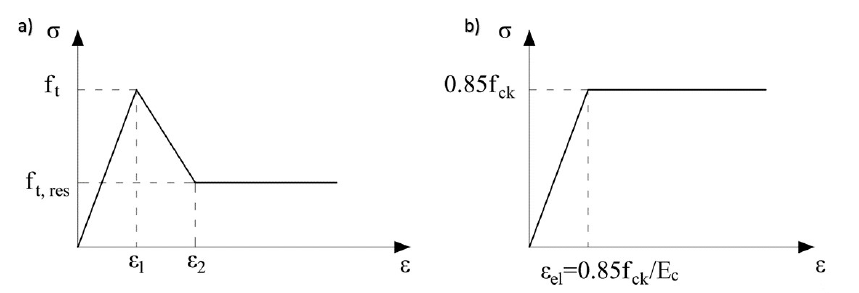
Figure 1. Stress–strain relation in ( a ) tension and ( b )